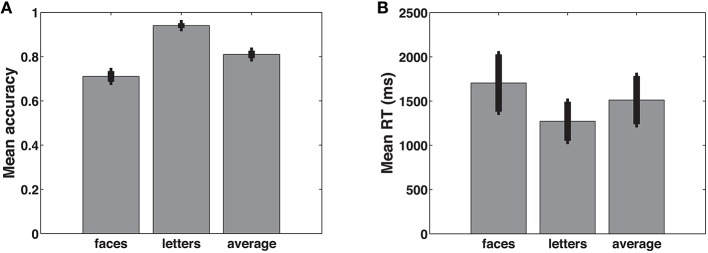
Mean accuracy (A) and reaction times (B) for faces, letters, and the average of the two. Error bars represent the standard error of the mean.